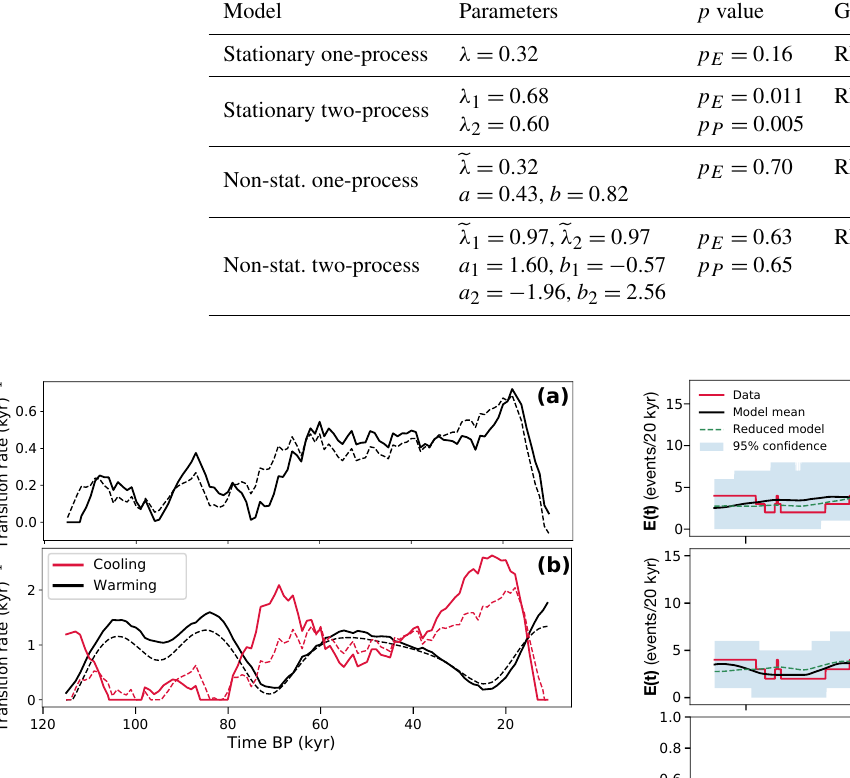
Figure 5. Time-varying transition rate parameters of the best-fit one-process λ ( t ) (a) and two-process (b) models λ 1 ( t ) and λ 2 ( t ), as well as of the reduced models (dashed lines).